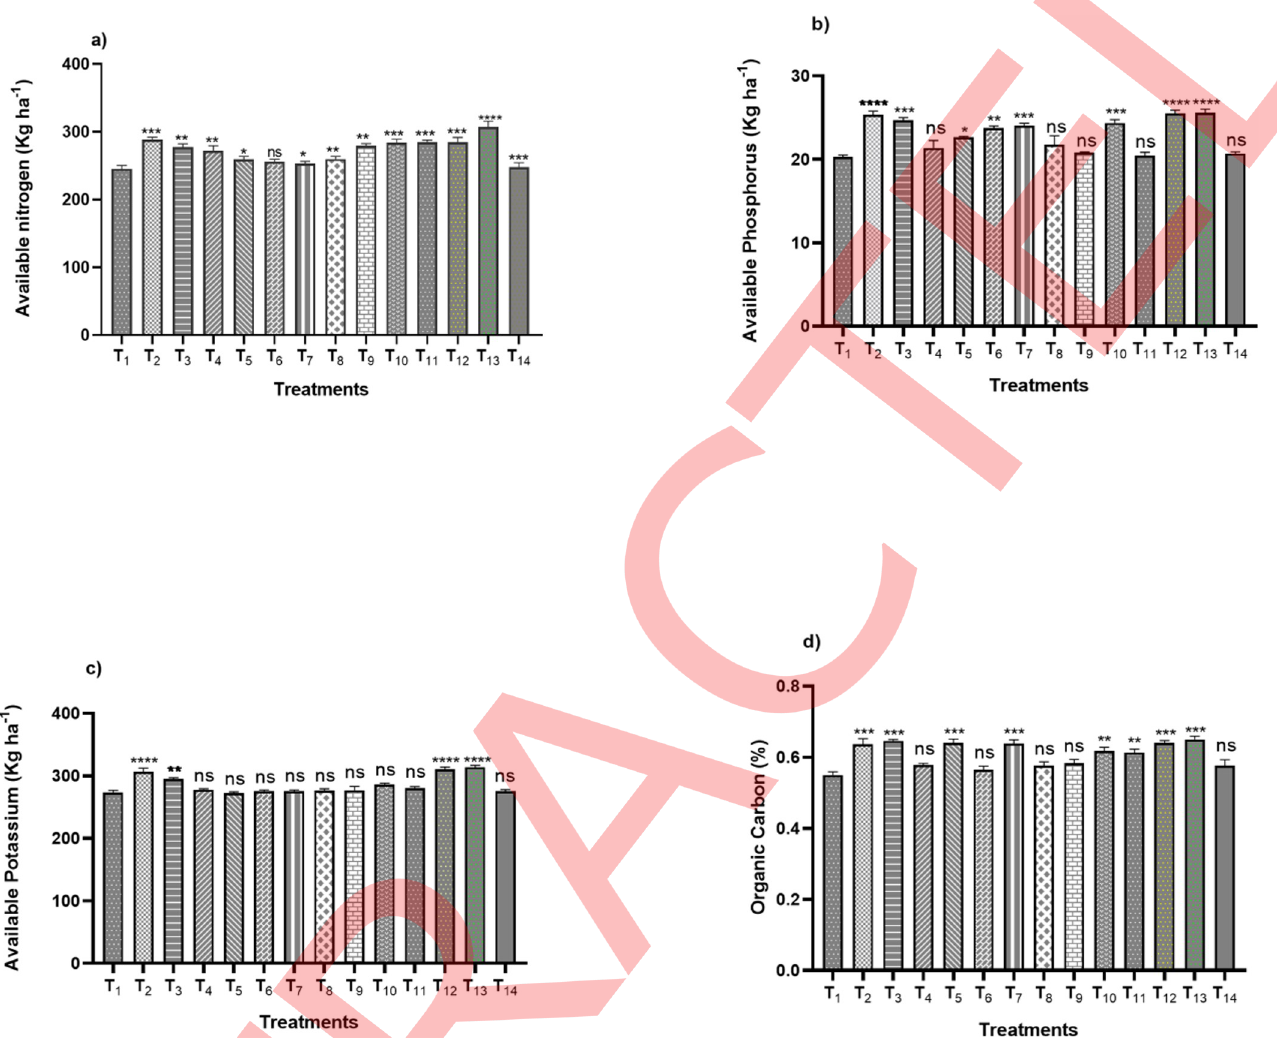
Fig 2. The effect of different organic manure treatments on soil chemical properties, where ( a ) Available nitrogen (AN); ( b ) Available phosphorus (AP); ( c ) Available potassium (AK); d) Organic carbon (OC). Various asterisk on bars show the significant differences ( P < 0.05) with vertical bars as standard errors ( n = 4) ( ���� > ��� > �� > � >